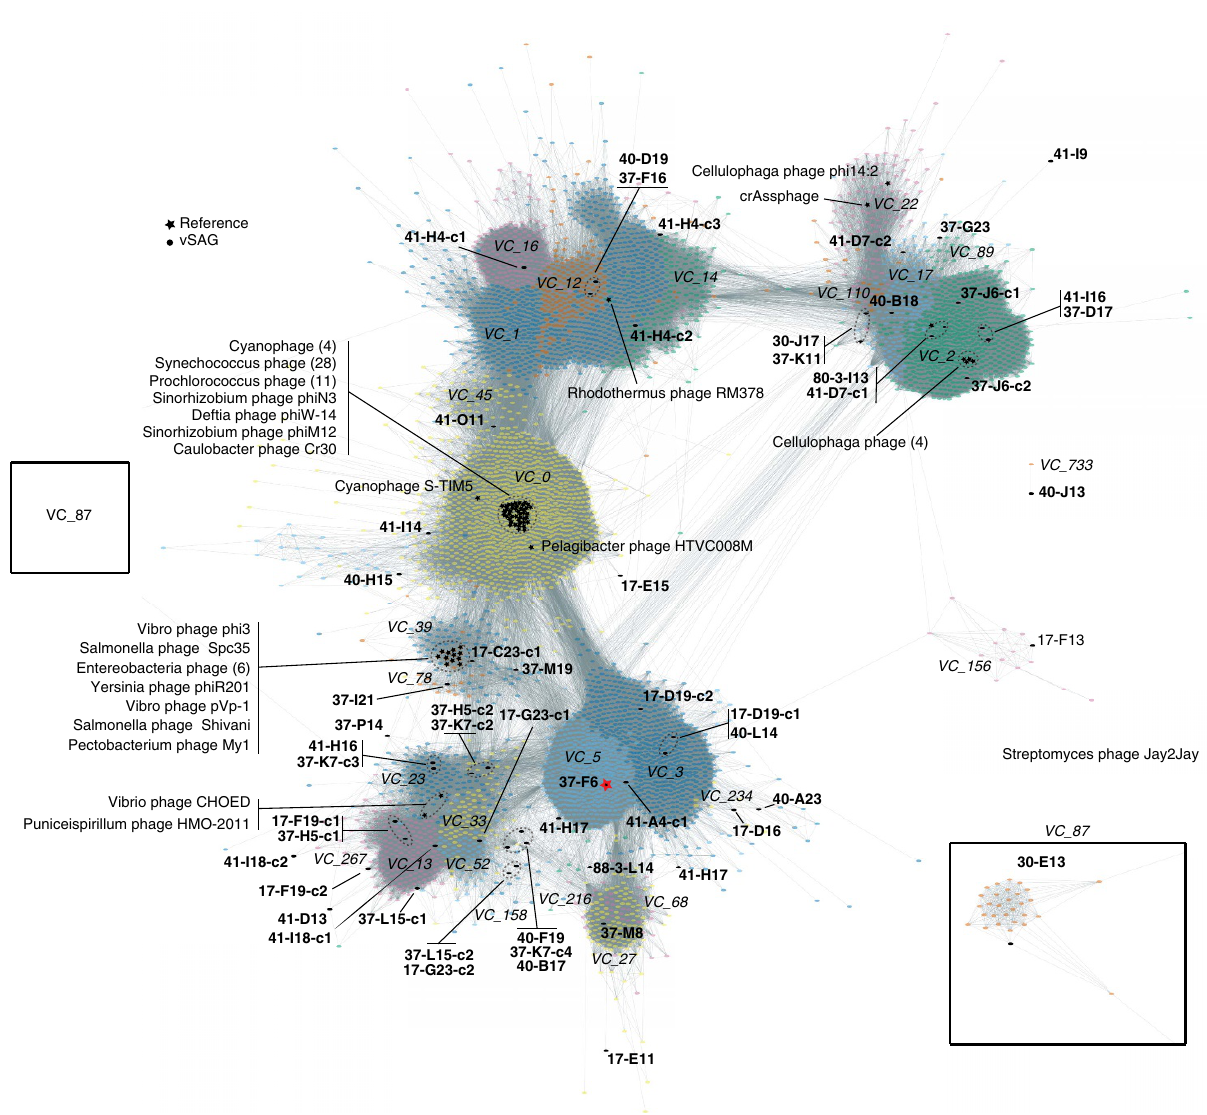
Figure 1 | Global viral protein-sharing network. A total of 5,539 partial and full-length genomes, and 634,497 relationships (edges) from GOV 2 , environmental phage from Genbank, archaeal and bacterial viral references (indicated by a black star, *), and vSAGs (this study, indicated by a black dot (cid:2) , bold font) were included in the analyses. Only viral clusters—with each viral cluster indicated by unique colours—including Z 1 vSAG sequences are represented. Edges between nodes indicate a statistically significant weighted pairwise similarity between the protein profiles of each node (see Methods) with similarity scores Z 1. Viral clusters (italic font) are determined by applying the Markov Cluster Algorithm (MCL) to the edges 2 . vSAG 37-F6 is indicated by a red